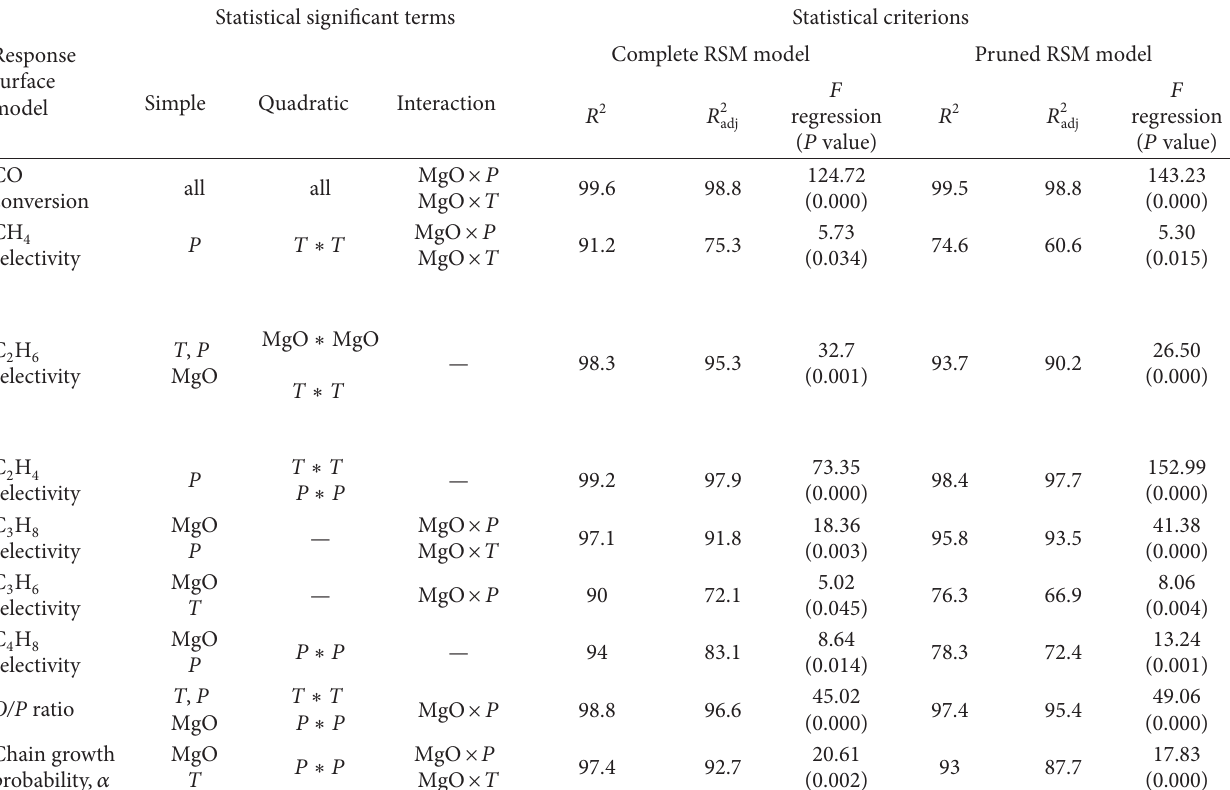
T 2: Results of response surface methodology for different